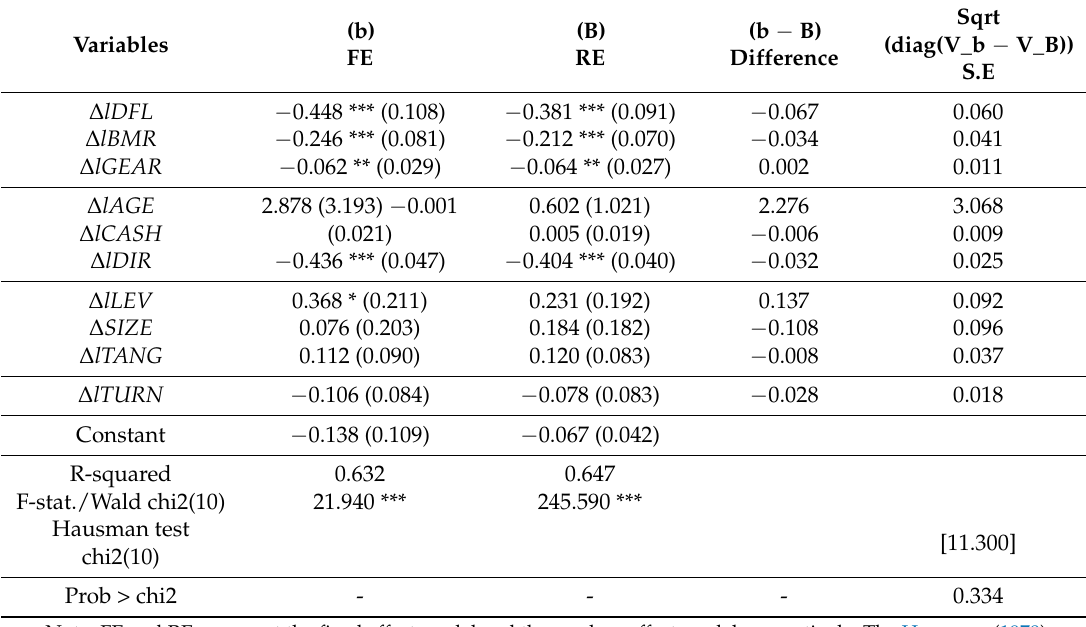
Table A3. Hausman test between the fixed effects model and the random effects model (Model 1).